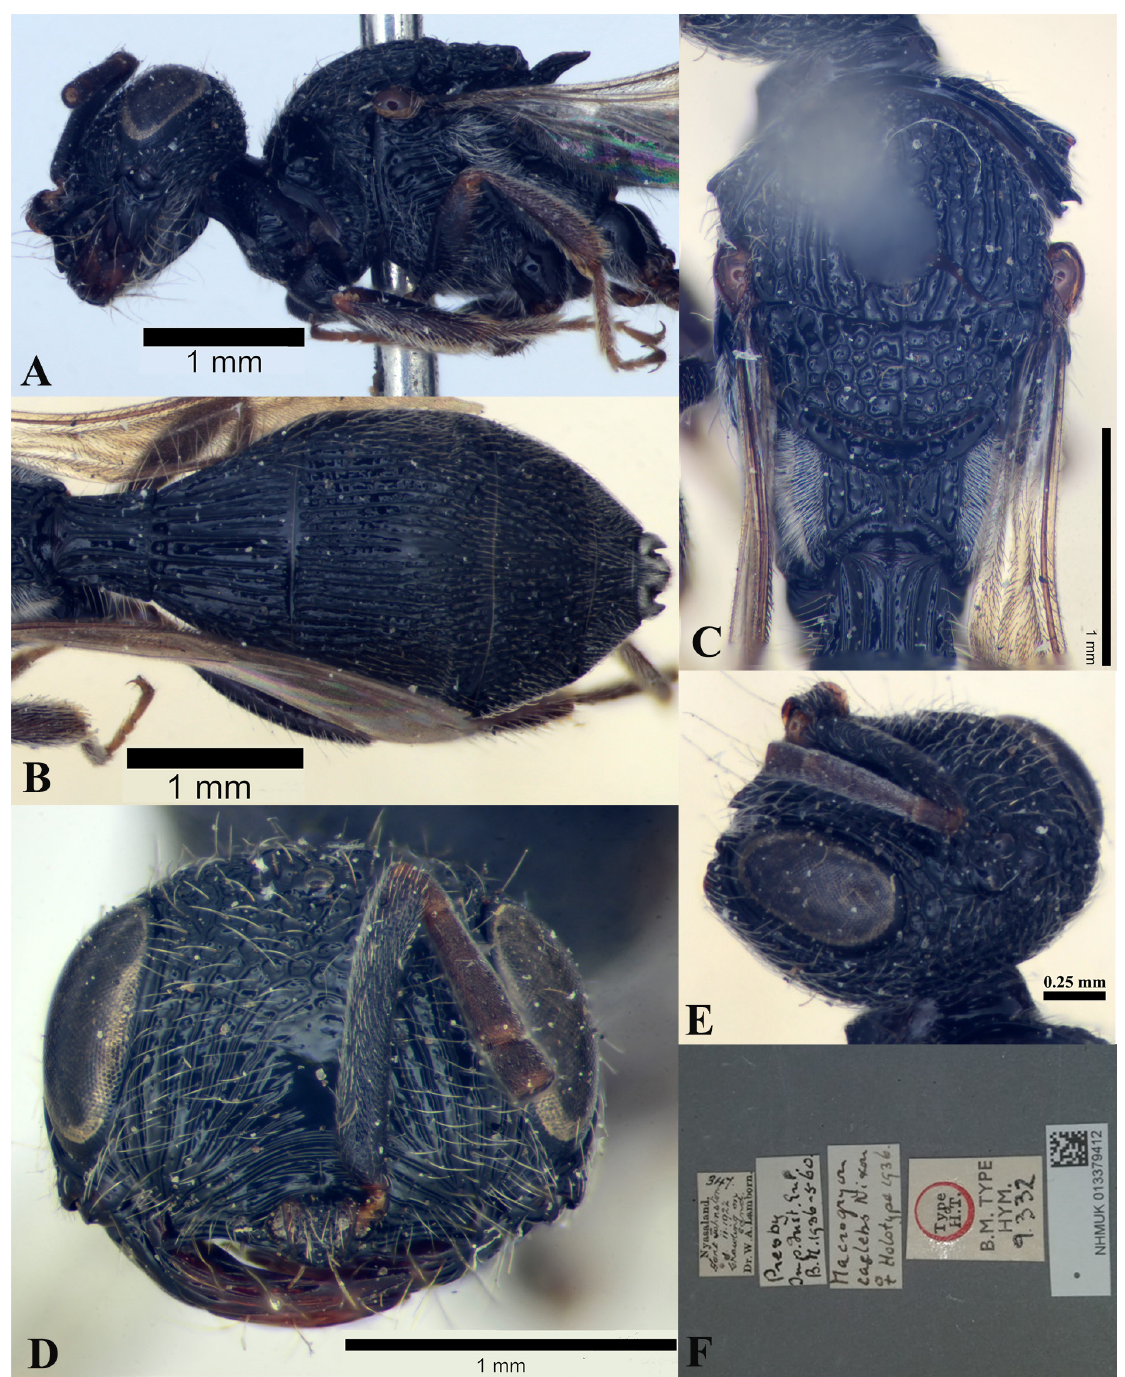
Fig. 10. Odontoscelio caelebs (Nixon, 1936). Holotype, ♀ (NHMUK 013379412). A . Head and pleuron. B . Metasoma. C . Mesonotum. D . Frons. E . Head. F . Type label. Photos: D.G. Notton © ,